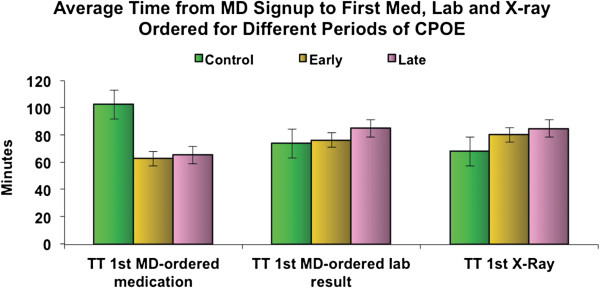
Average time from MD signup to first med, lab and X-Ray ordered for different periods of CPOE.